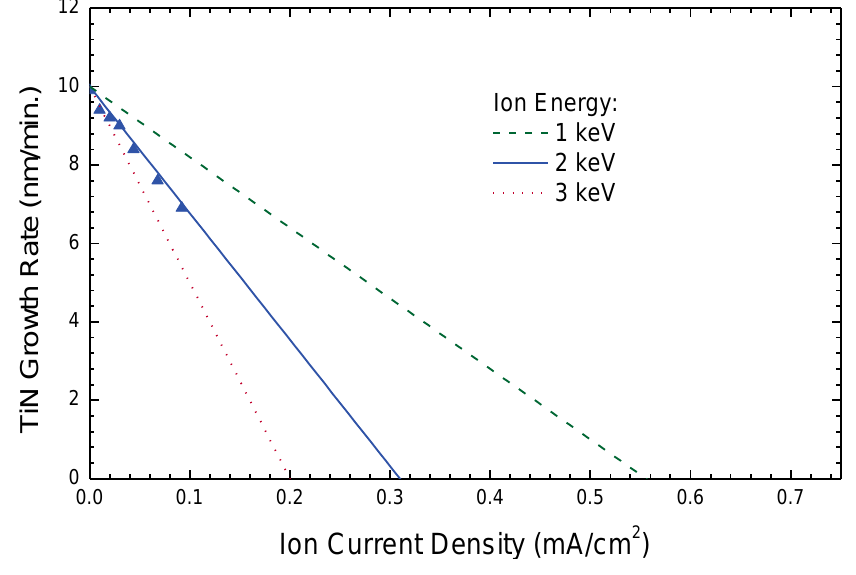
Figure 6 . Variation of the growth rate for TiN thin films produced by ion beam assisted deposition (IBAD) with nitrogen ions of different energies at fixed titanium evaporation rate. As the sputter rate increases with ion energy in the range of interest, a higher ion energy leads to a reduced growth rate. The triangles indicate measured data points, the lines are from simulations using calculated sputter yields from Reference